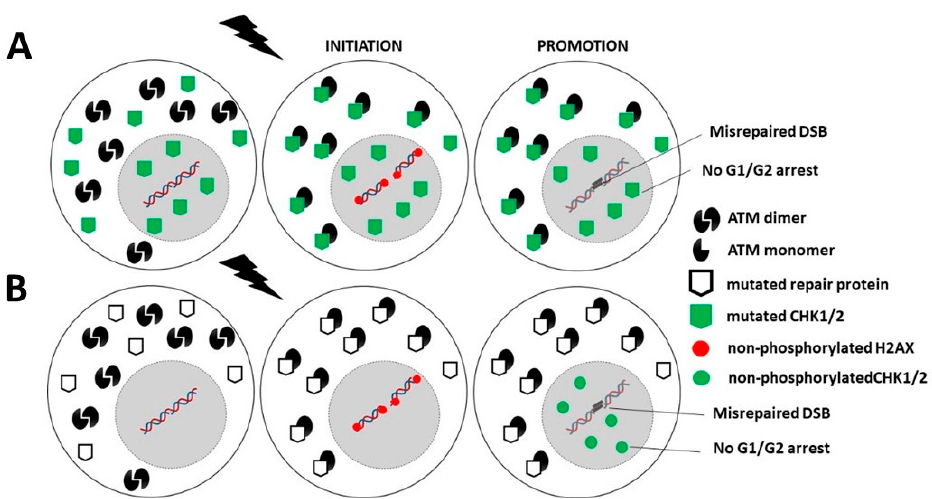
Figure 5. Schematic representation of the RIANS model in cells from Category 2 and 3 cancer syndromes. ( A ). Category 2: Mutated genes are involved in cell cycle checkpoint control. The encoded proteins are X-proteins. The RIANS is delayed by the high cytoplasmic expression of X-proteins, and few ATM monomers enter into the nucleus. Consequently, few DSB are recognized by NHEJ and therefore may be misrepaired. ( B ). Category 3: Mutated genes are directly involved either in DNA damage recognition and repair or in the cell cycle checkpoint control. The encoded proteins are X-proteins. The RIANS is therefore delayed by the cytoplasmic overexpression of X-proteins, and few ATM monomers may enter into the nucleus. Consequently, few DSB are recognized by NHEJ and therefore may be misrepaired. Furthermore, CHK proteins are not phosphorylated, and therefore, G1/G2 arrests are impaired.